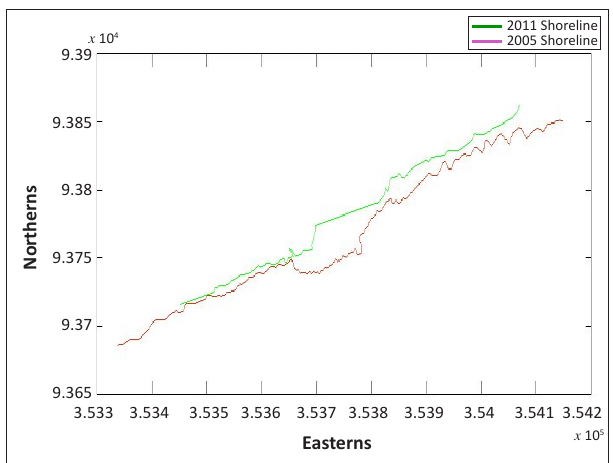
FIGURE 6 : Overlay of digitised and mapped shorelines in MATLAB.